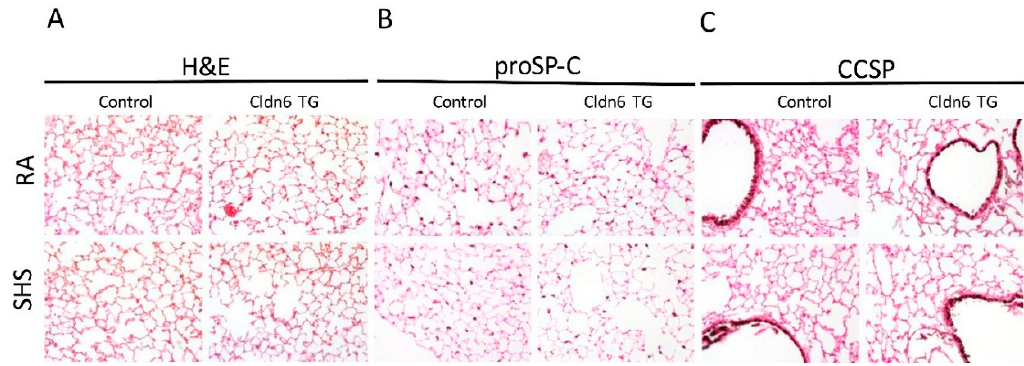
Figure 2. Representative sections of lung tissue were stained with Hematoxylin and Eosin (H&E) ( A ), propeptide of Surfactant Protein-C (proSP-C) ( B ); or Club Cell Secretory Protein (CCSP) ( C ). No observable anatomical disturbances were observed in the respiratory regions or conducting airways ( A ). Furthermore, no qualitative differences were detected in lung sections when alveolar type II cells ( B ) or non-ciliated proximal epithelial cells were counted ( C ). No staining was observed in controls that lacked primary antibody (not shown). Images (200× magnification) are representative of experiments involving four animals from each group.